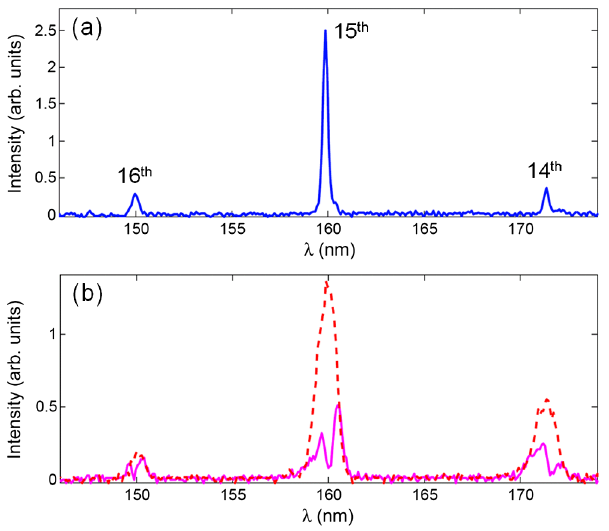
FIG. 5. Ten consecutive radiation spectra for EEHG (a) and HGHG (b) with an unchirped